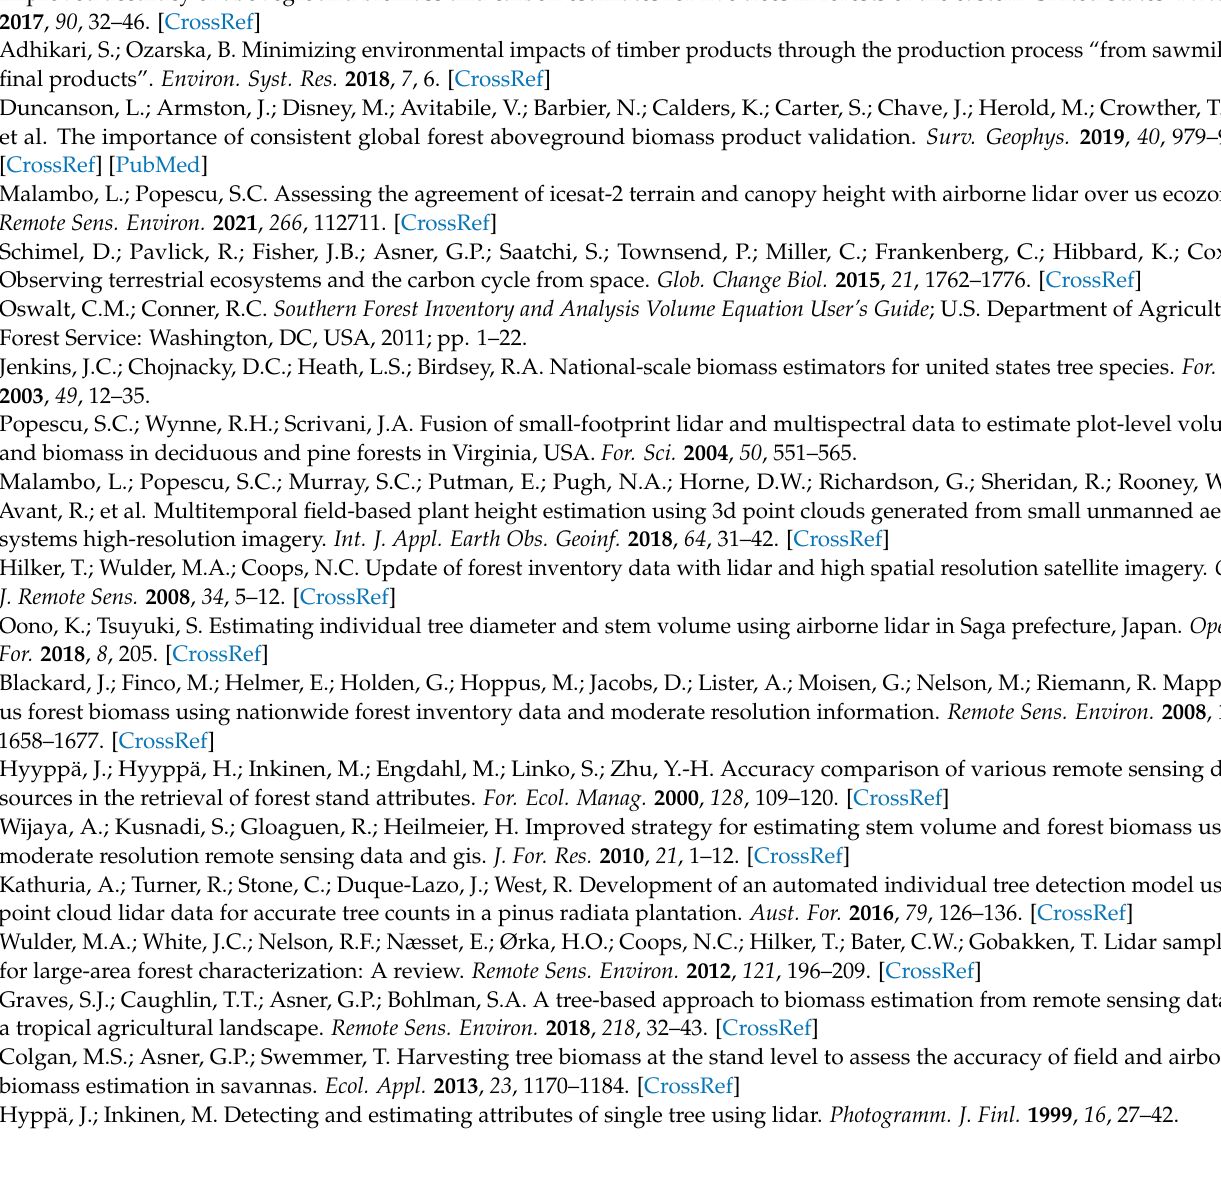
Using Equations (A1) and (A2), the corresponding RMSE and rRMSE values for the county-level comparison (MAE = 1.58 million cubic meter, pMAE = 11.7%) are 2.3 million cubic meters and 14.0%,